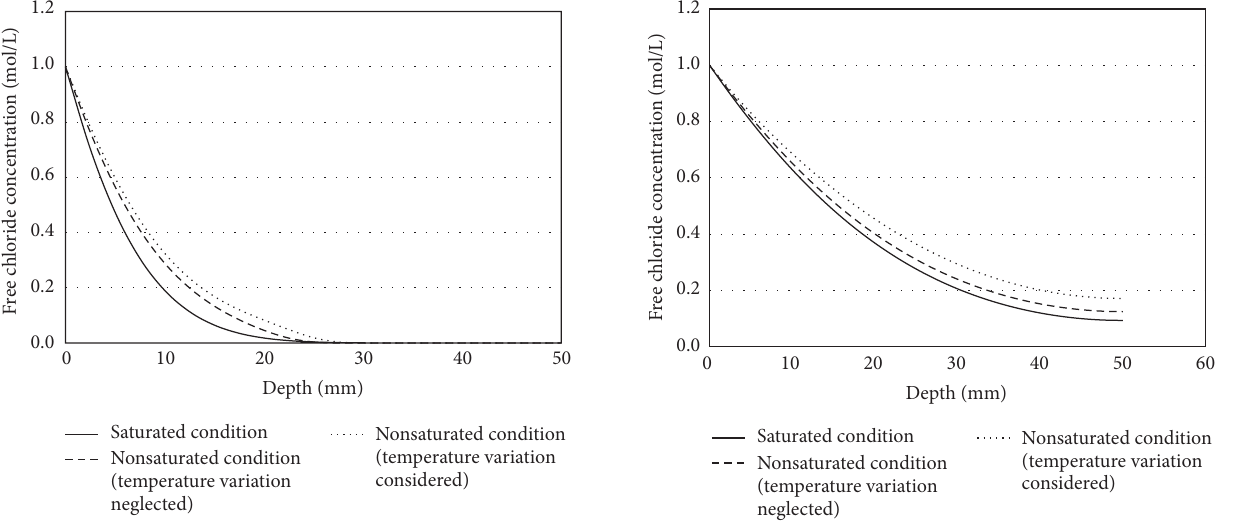
Figure6:Freechlorideconcentrationprofilesat10daysofexposure.